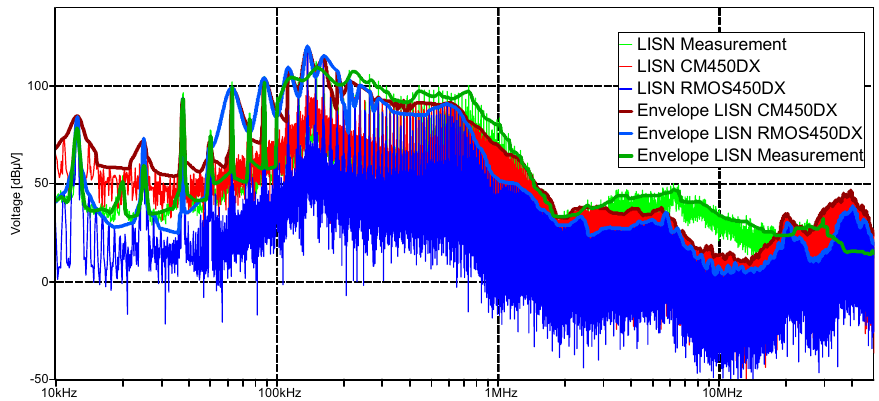
Figure 27. Measurement and modeling comparison.